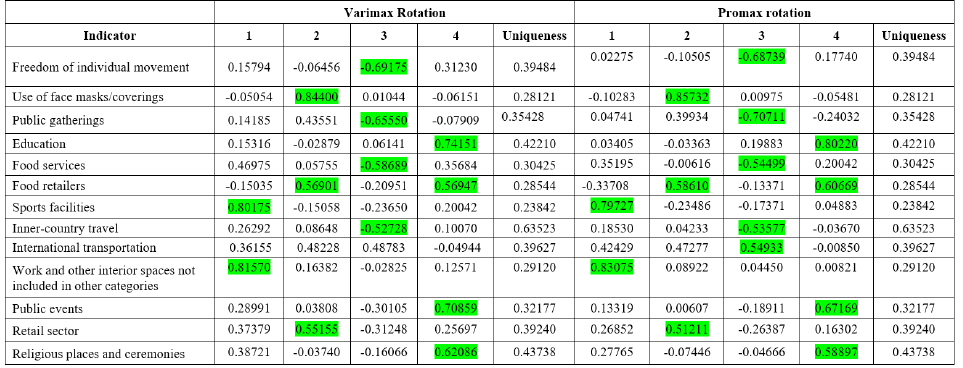
Highlighted area indicates significant correlation with latent